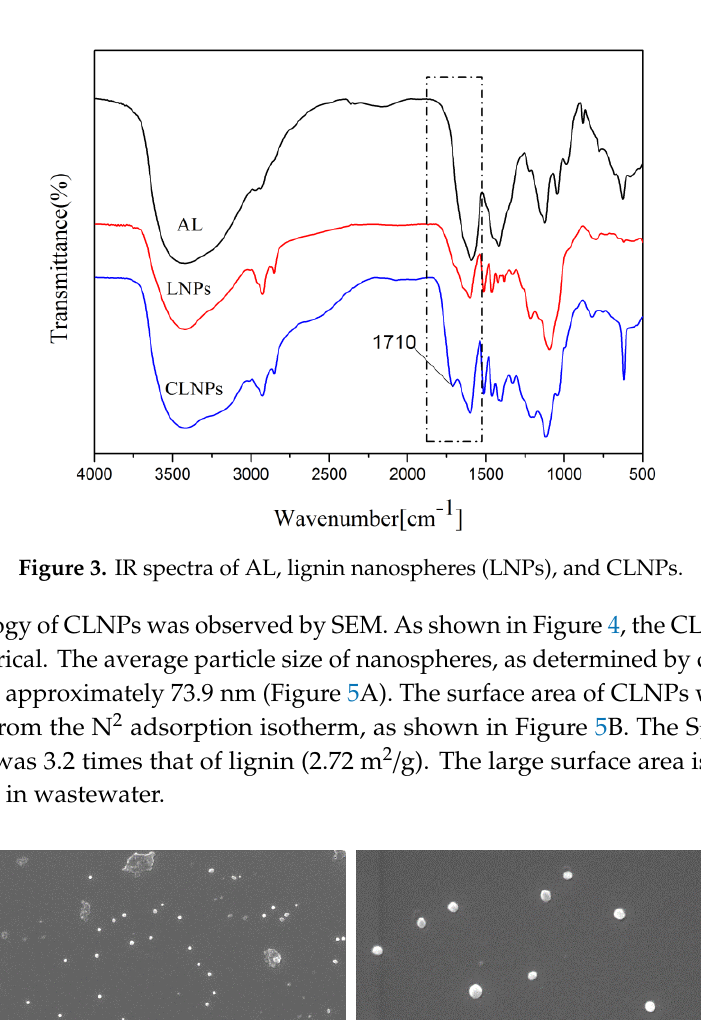
Figure 3. IR spectra of AL, lignin nanospheres (LNPs), and CLNPs.